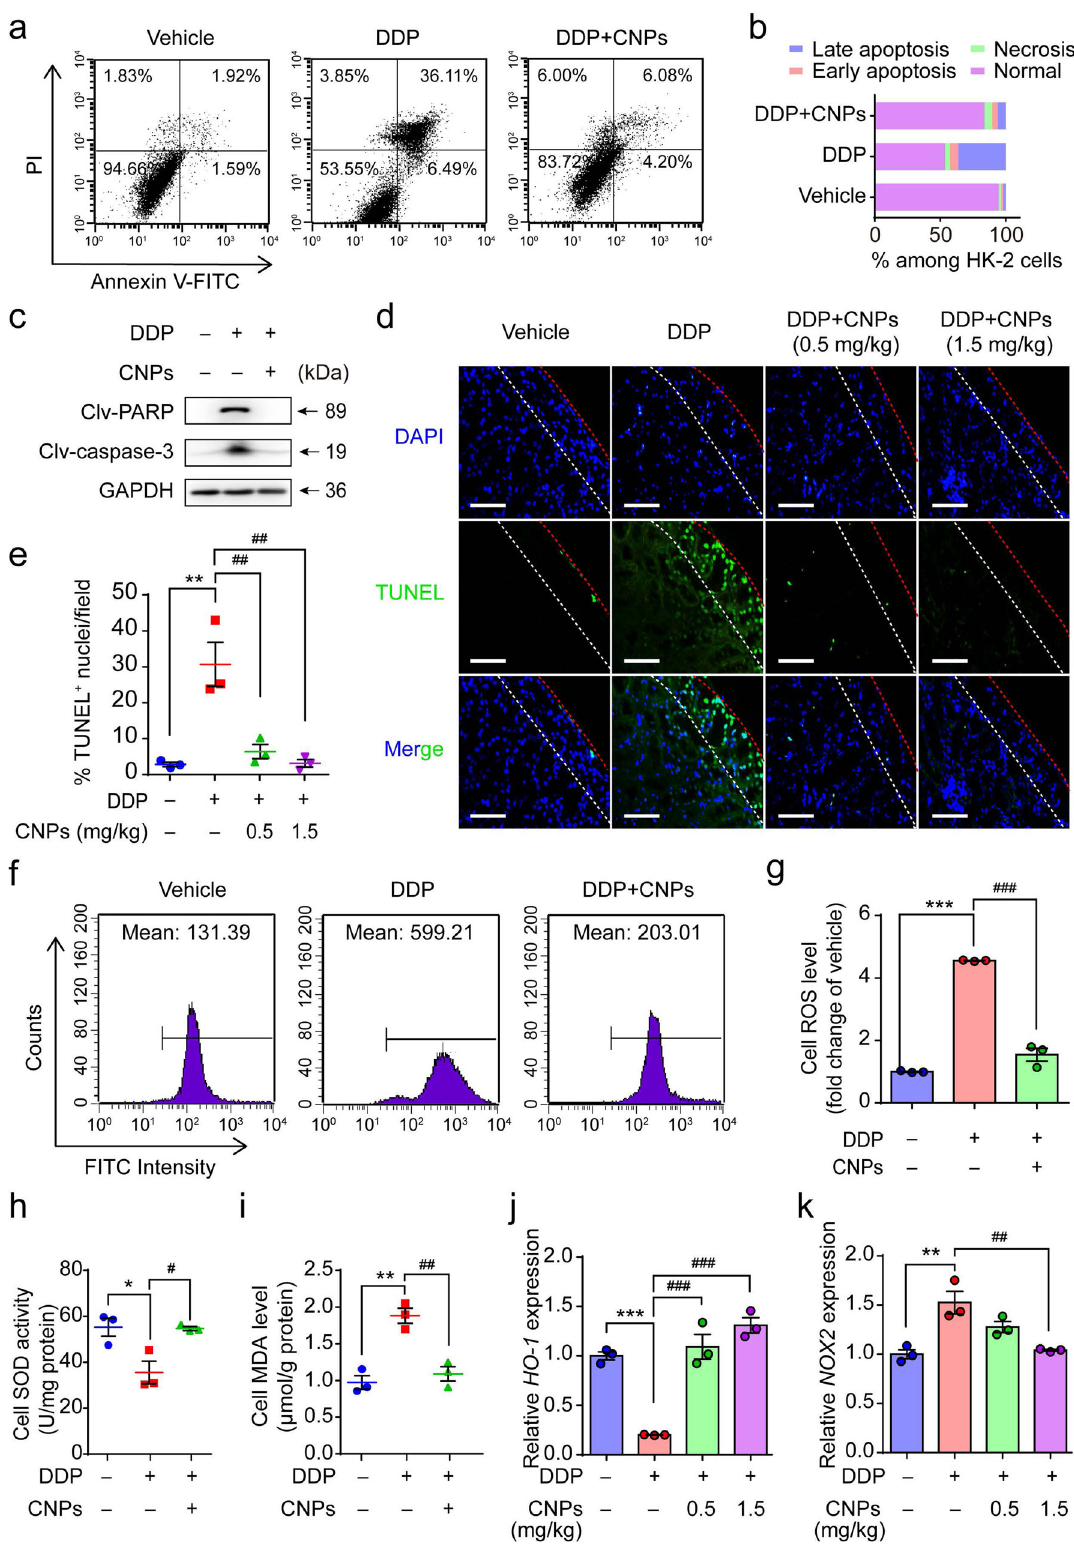
administered into ES-2 tumor xenograft nude mice, followed by CNPs or NAC treatment (Fig. 6a). The body weights of mice treated with DDP show negligible change as compared to that of the vehicle group (Supplementary Figs. 25 and 26), indicating that DDP at this dosage and administration frequency do not cause